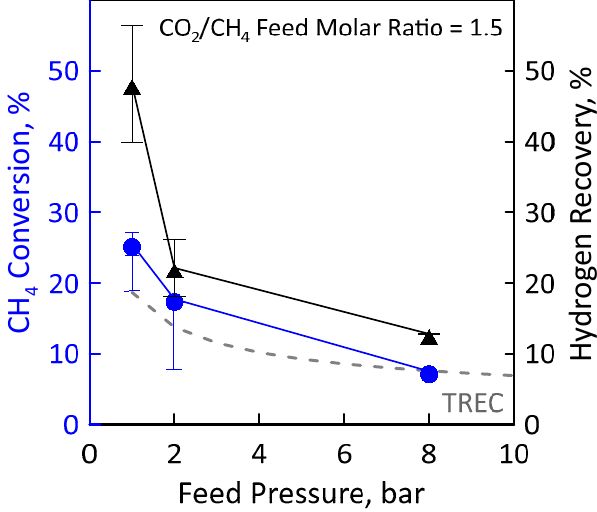
Figure 12. CH 4 conversion ( ● ) and H 2 recovery ( ▲ ) as a function of feed pressures at CO 2 /CH 4 feed molar ratio = 1.5, permeate pressure = 0.02 bar. Equilibrium conversion values in a traditional reactor (dashed line).